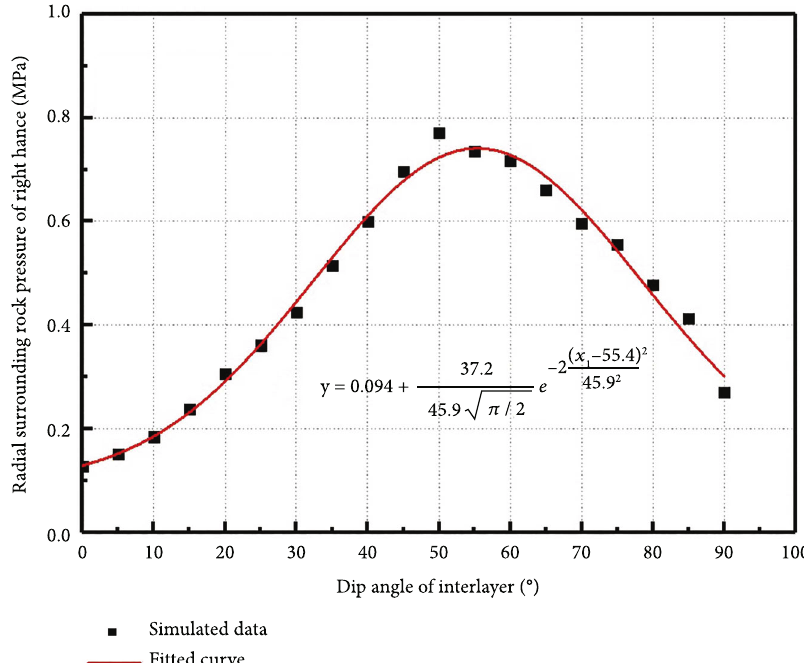
Figure 5: Fitting curve of the relationship between the surrounding rock pressure of right hance and the weak interlayer with di ff erent dip angles.